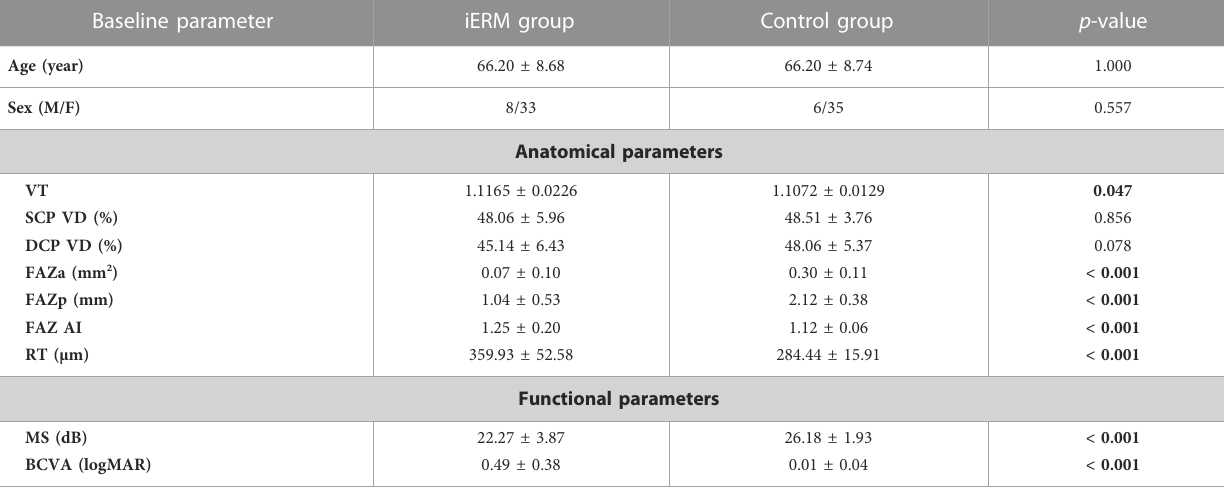
TABLE 1 Comparison of baseline parameters between the iERM (N = 41) and control (N = 41) groups. Baseline parameter